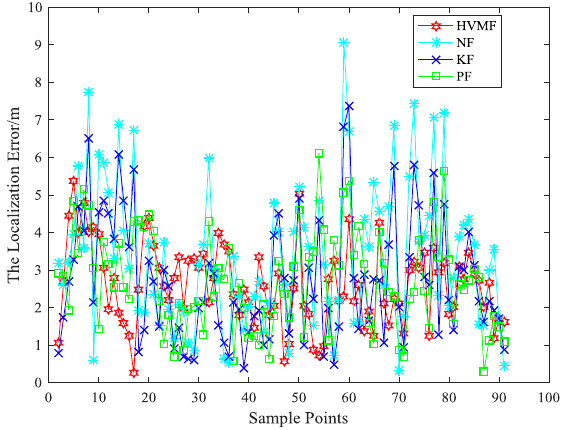
Figure 6. The localization error in each sample point.